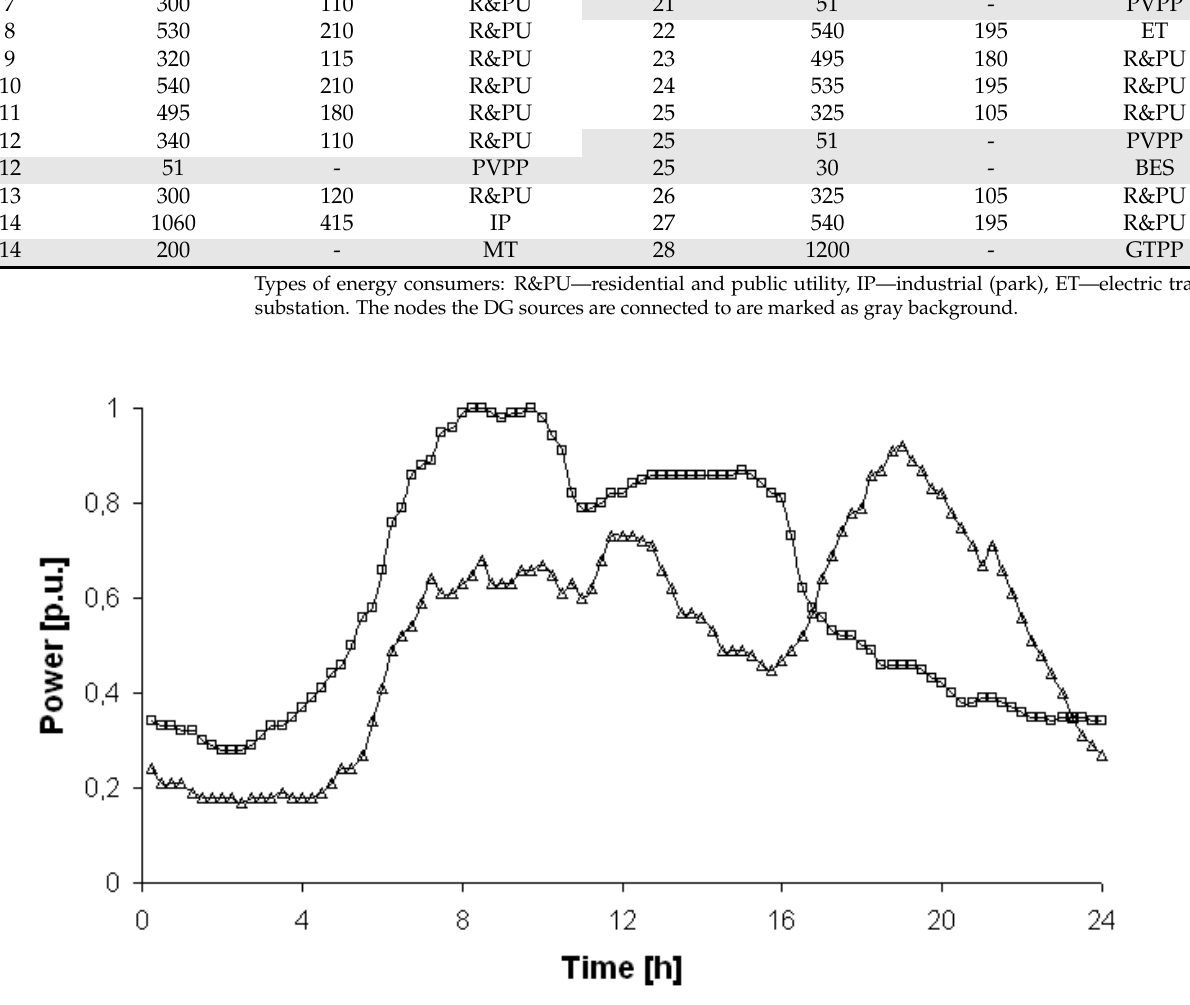
Figure A2. Typical daily load profile (15-min intervals) for residential consumers (a line with the triangles) as well as industrial parks and electric traction substation (a line with the quadrants); based on [85]. Table A2. Line parameters of the urban MV distribution network. From Node No.